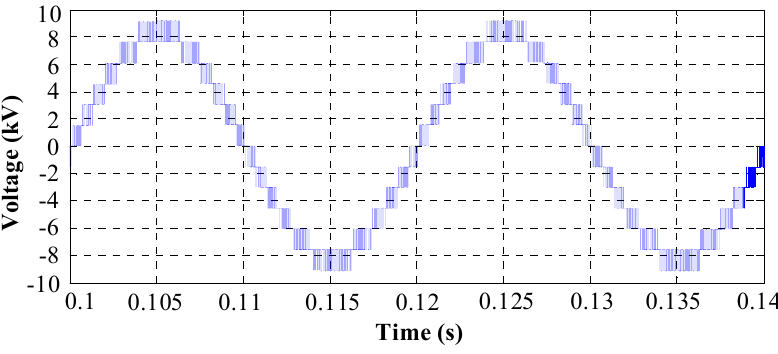
Figure 7. Phase A stack output voltage.